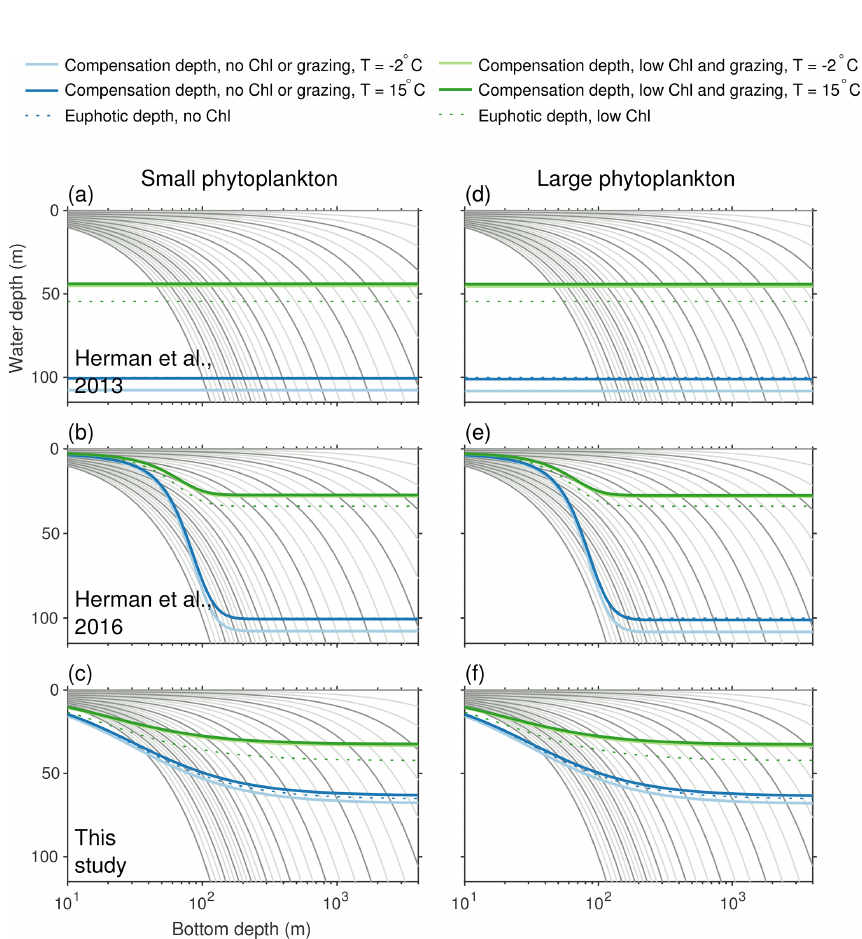
Figure B1. Compensation depth (depth where photosynthesis balances phytoplankton loss terms) and euphotic depth (depth of 1% PAR) in three versions of the BESTNPZ model, under low (light-colored) and high (dark-colored) temperature conditions, assuming a surface irradiance of 200Wm − 2 and nutrient-replete waters. The “no Chl or grazing” scenario (blue) assumes losses due to respiration and non- predatory mortality only, with no attenuation due to phytoplankton itself. The “low Chl and grazing” scenario (green) assumes attenuation due to 0.5mmolChl a m − 3 throughout the water column and adds a constant grazing loss rate of 0.05d − 1 . Gray lines indicate boundaries of the ROMS depth levels in the 10-layer (dark) and 30-layer (light) versions of the model. (Note that values are very nearly identical for small and large phytoplankton due to the proportional scaling of rate parameters between the